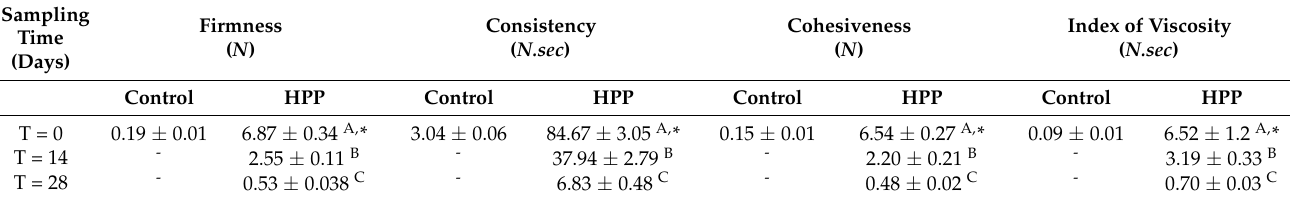
Table 3. Textural parameters obtained by back extrusion